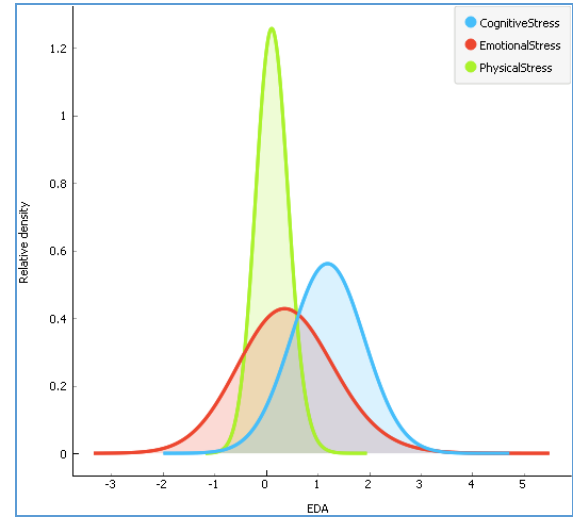
Figure 4. The distribution of according to three stress types.